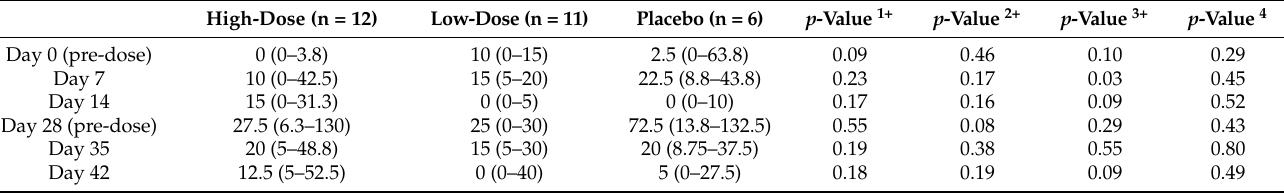
Figure 3. Reactogenicity events reported for the 14-day period after each vaccination with DelNS1- nCoV-RBD LAIV. Subjects received two doses of test vaccine or placebo on day 1 and day 29, and were then required to record any AE in the diary for a 14-day period after each vaccination. ( A ) AE occurred in subjects after the first vaccination. ( B ) AE occurred in subjects after the second dose. Fisher’s exact test was used to analyze the AEs in the three groups. Table 3. Summary of T-Cell ELISpot response.